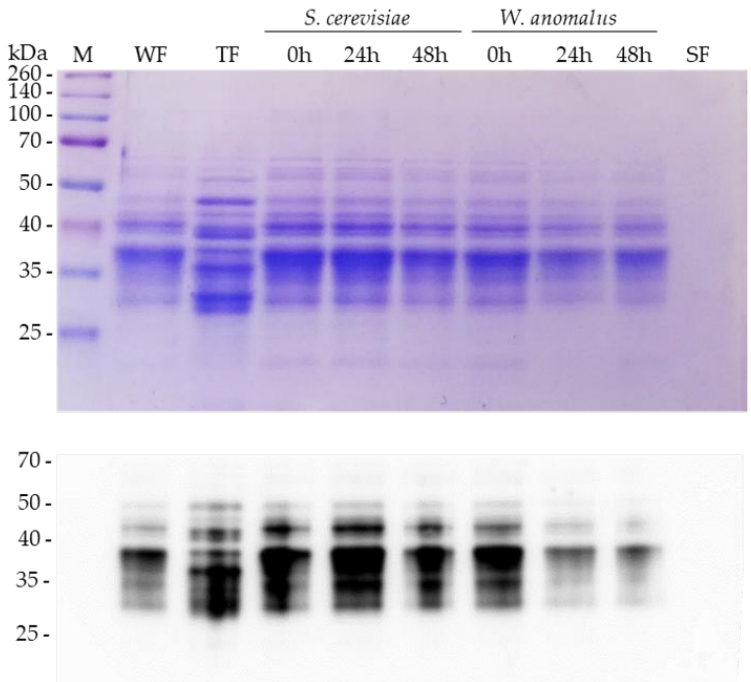
Figure 5. Hydrolysis of gliadins by W. anomalus in wheat flour fermentation. Top, SDS-PAGE analysis of the gliadin fraction extracted from unfermented flours (WF, TF, SF) and S. cerevisiae - or W. anomalus - fermented wheat flour (WF) dough. The fraction of gliadins extracted from samples taken at 0 h, 24 h, and 48 h after yeast inoculation is shown for fermented dough. WF, bakery flour V-25; TF, tritordeum hybrid cereal flour; and SF, soybean flour. Bottom analysis by immunoblotting of the gliadin fractions extracted from the duplicates of each sample analyzed at the top (flours and yeast-fermented dough). Gliadin proteins were detected by polyclonal anti-wheat gliadin